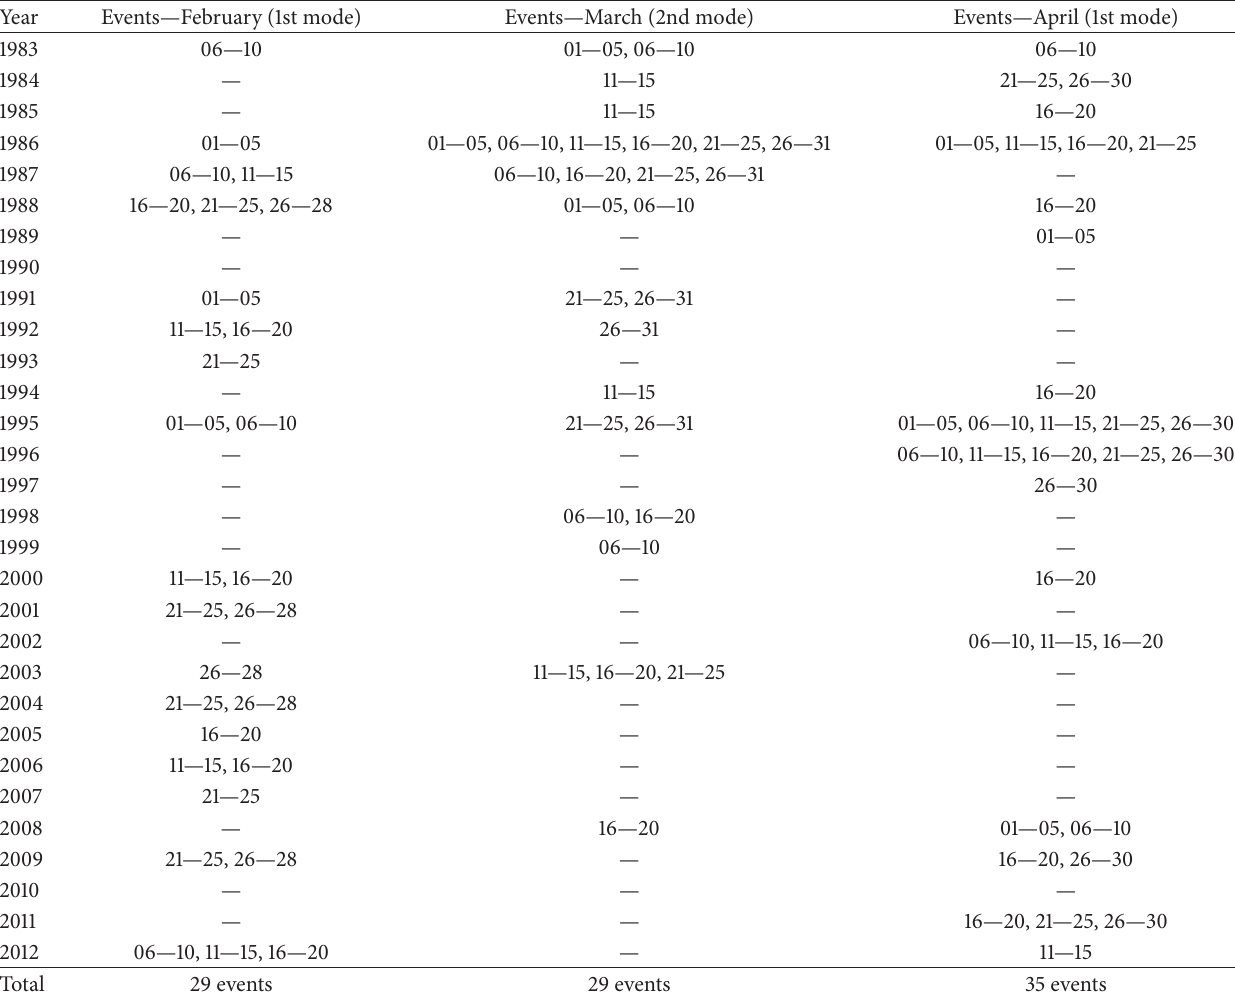
Table 1: Dates of pentads events selected objectively by PC obtained by theEOF technique, applied in February, March, and April (1983–2012),